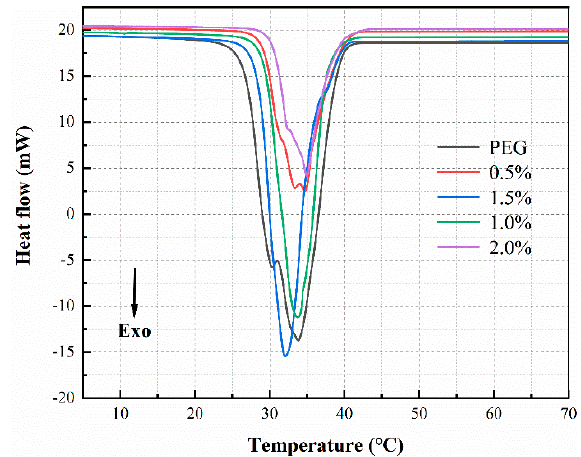
Figure 5. Solidifying DSC curves of the pure PEG and PEG/GNPs composites with the different contents of GNPs.